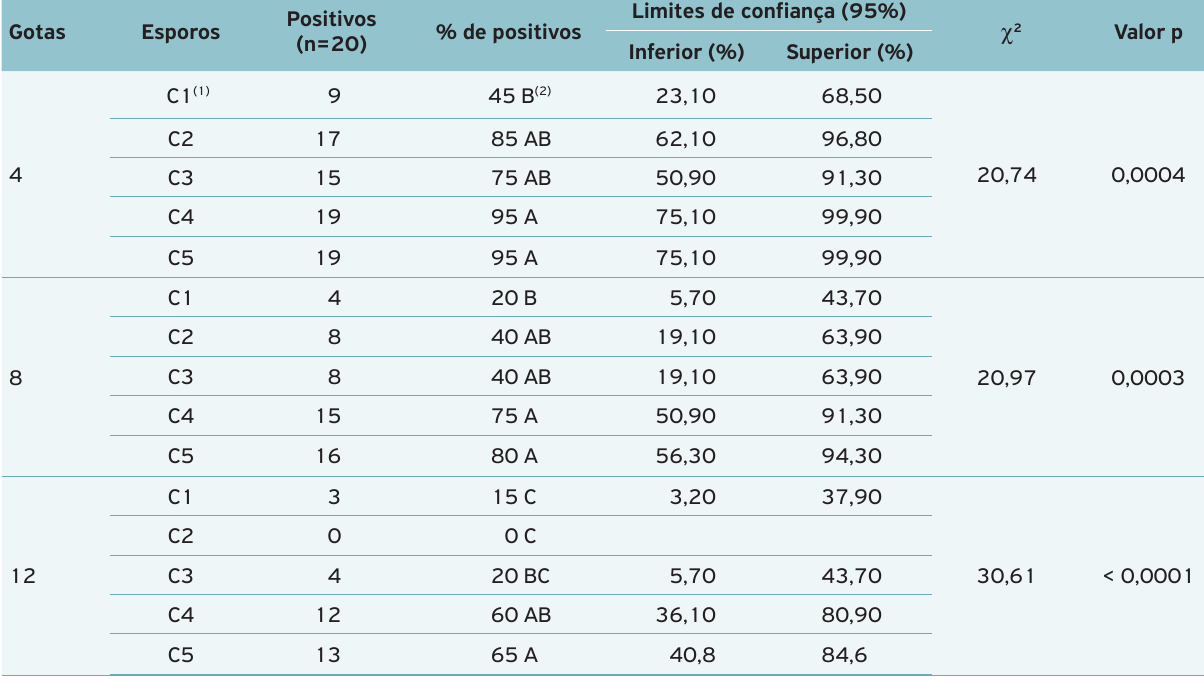
Tabela 2. Intervalo de confiança para a comparação entre a proporção de resultados positivos às classes de número de esporos dentro de cada quantidade de